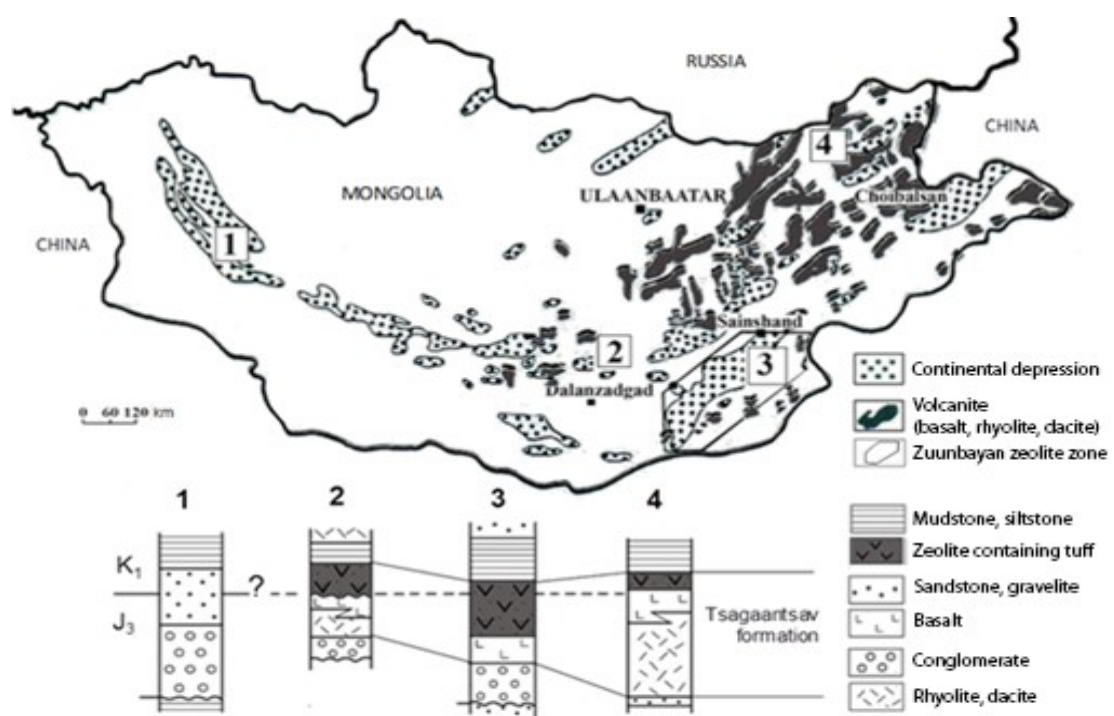
Fig. 2. Geological and paleogeographical conditions to form natural zeolite in